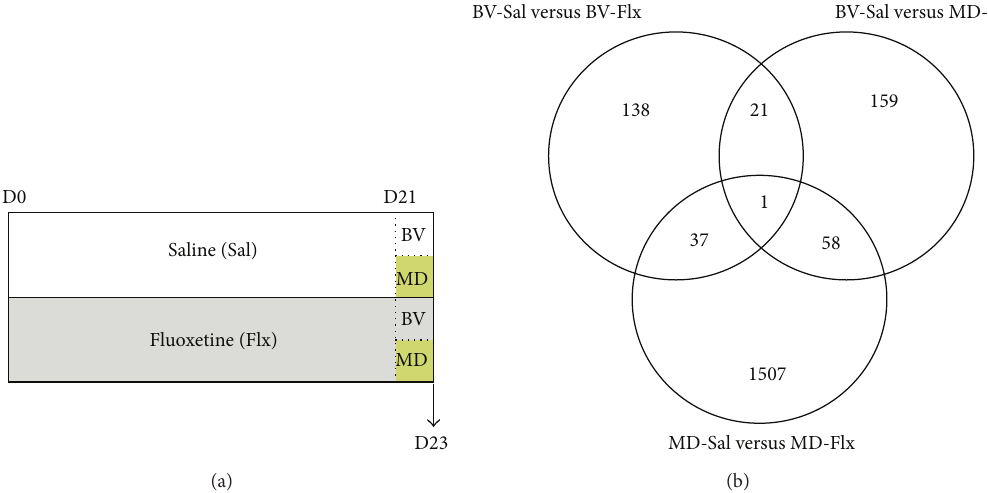
Figure 1: Experimental design and Venn diagram. (a) Schematic graph showing the different animal groups and experimental conditions conducted. (b) Venn diagram showing the number of genes differentially expressed when comparing the effects of monocular deprivation (BV-Sal versus MD-Sal), the effects of fluoxetine in animals with binocular vision (BV-Sal versus BV-Flx), and those of fluoxetine in animals with monocular deprivation (MD-Sal versus